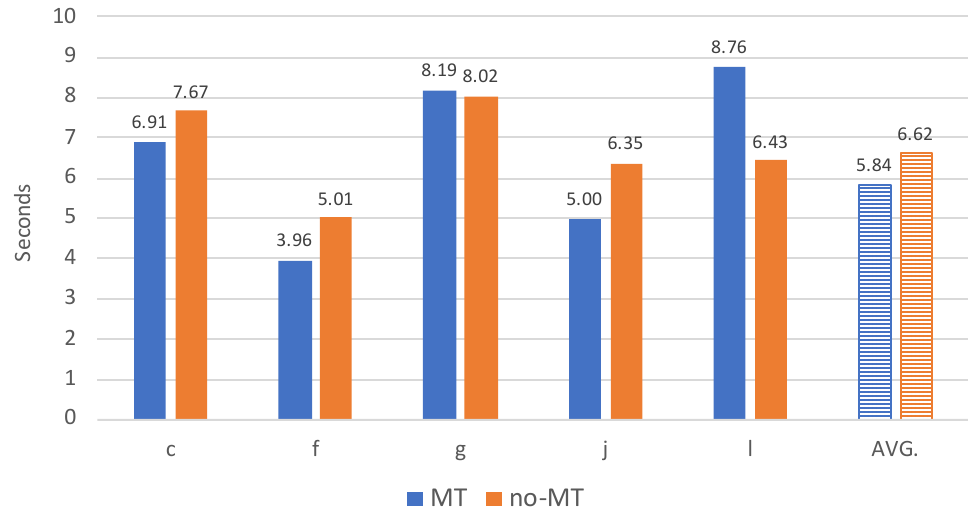
Figure 3. Average processing speed per task (expressed in seconds per source token) for five translators from the French language department. ‘AVG.’ stands for the average processing speed per task for all translators of the French language department.